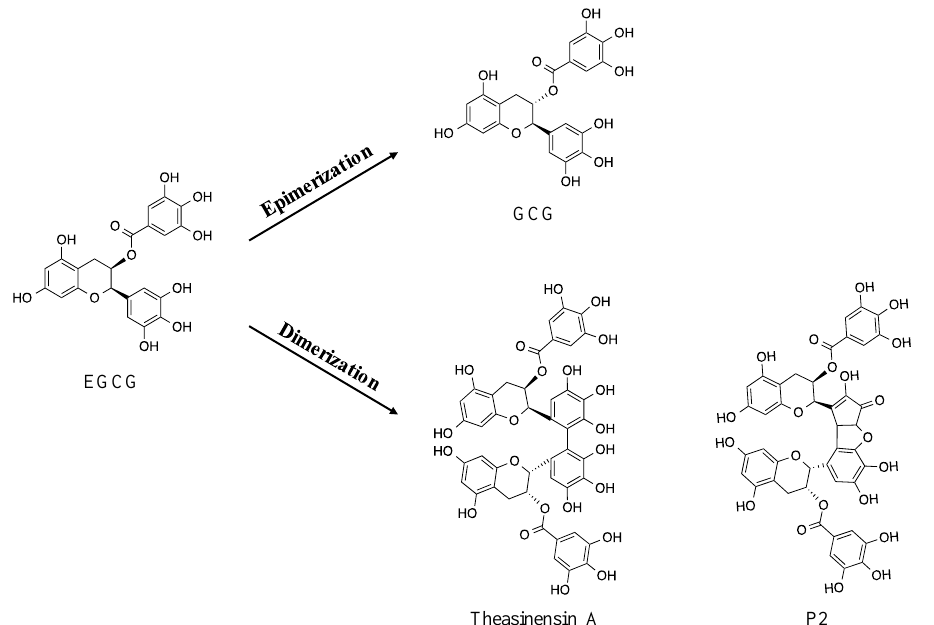
Figure 2. Under common experimental conditions, epigallocatechin-3-gallate (EGCG) forms gallocatechin-3-gallate (GCG) through epimerization, and theasinensin A and P2 through oxidation-induced dimerization.